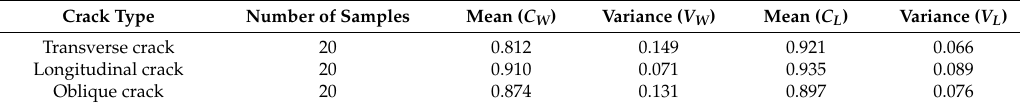
Table 3. Quantitative evaluation of the width / length compliance of 3 types